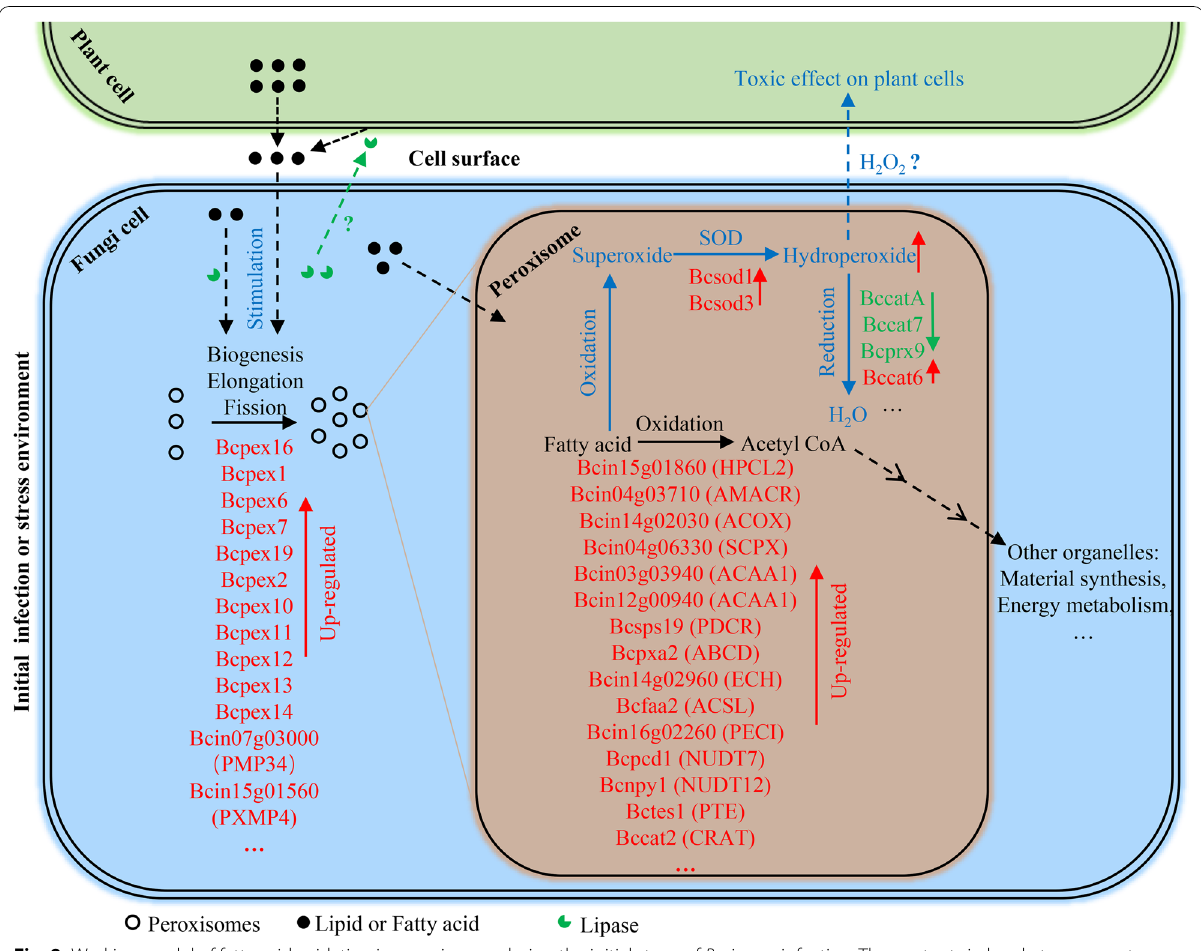
Fig. 8 Working model of fatty acid oxidation in peroxisomes during the initial stage of B. cinerea infection. The contents in brackets represent the symbols according to the KEGG results. ABCD, ATP-binding cassette, subfamily D; ACAA, Acetyl-CoA acyltransferase; ACOX, Acyl-CoA oxidase; ACSL, Long-chain acyl-CoA synthetase; AMACR, α-methylacyl-CoA racemase; CAT, Catalase; CRAT, Carnitine O-acetyltransferase; ECH, δ(3,5)-δ(2,4)-dienoyl-CoA isomerase; HPCL, 2-hydroxyacyl-CoA lyase; NUDT, Diphosphatase; PDCR, 2,4-dienoyl-CoA reductase; PECI, δ(3)-δ(2)-enoyl-CoA isomerase; pex, Peroxin; PMP and PXMP, Peroxisomal membrane protein; PTE, Acyl-CoA thioesterase; SCPX, Sterol carrier protein; SOD, Superoxide